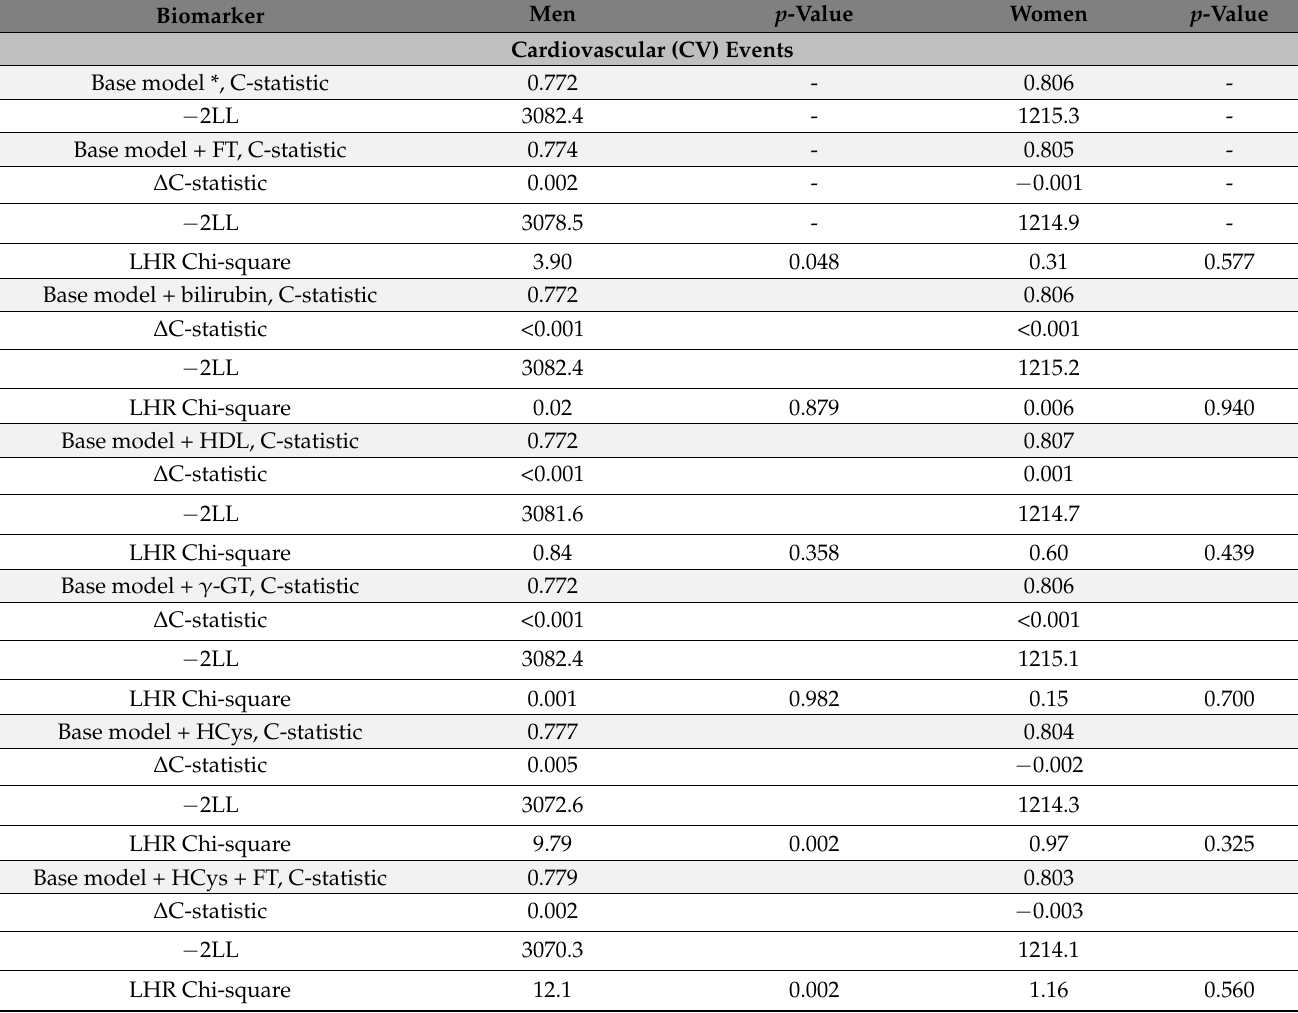
Table 3. Sex-specific incremental value of oxidative stress biomarkers over clinical risk factors in predicting the risk of CV events and all-cause